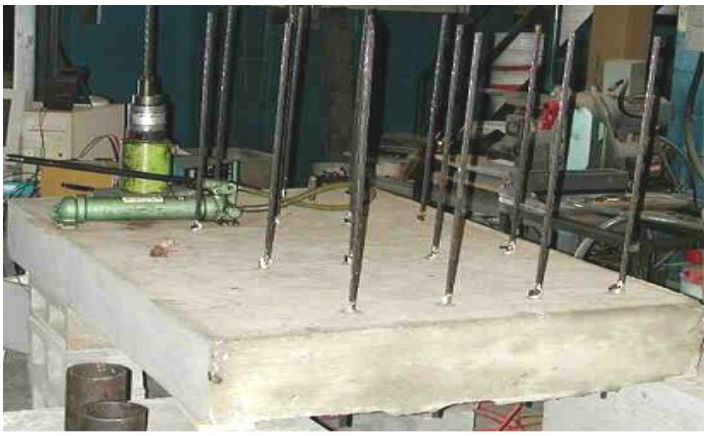
Figure 1. Prestressing strands embedded at various heights of wall element.